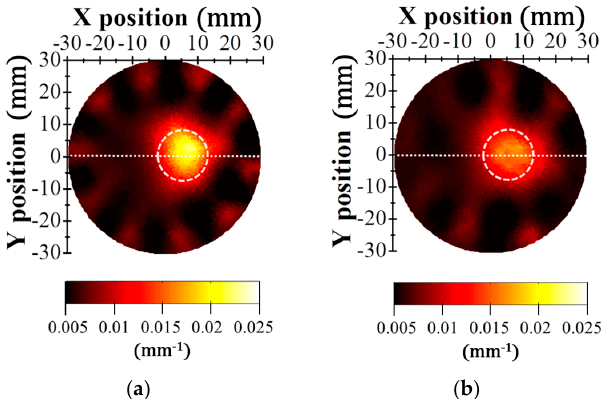
Figure 4. ( a ) Reconstructed tomographic images of the phantom absorption coefficients obtained by the TDM DOT and ( b ) FDM DOT systems.